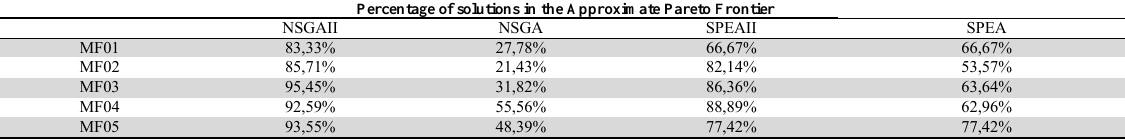
Percentage of solutions contributed by NSGAII, NSGA, SPEAII and SPEA to the Approximate Pareto Frontier Percentage of solutions in the Approximate Pareto Frontier NSGAII NSGA